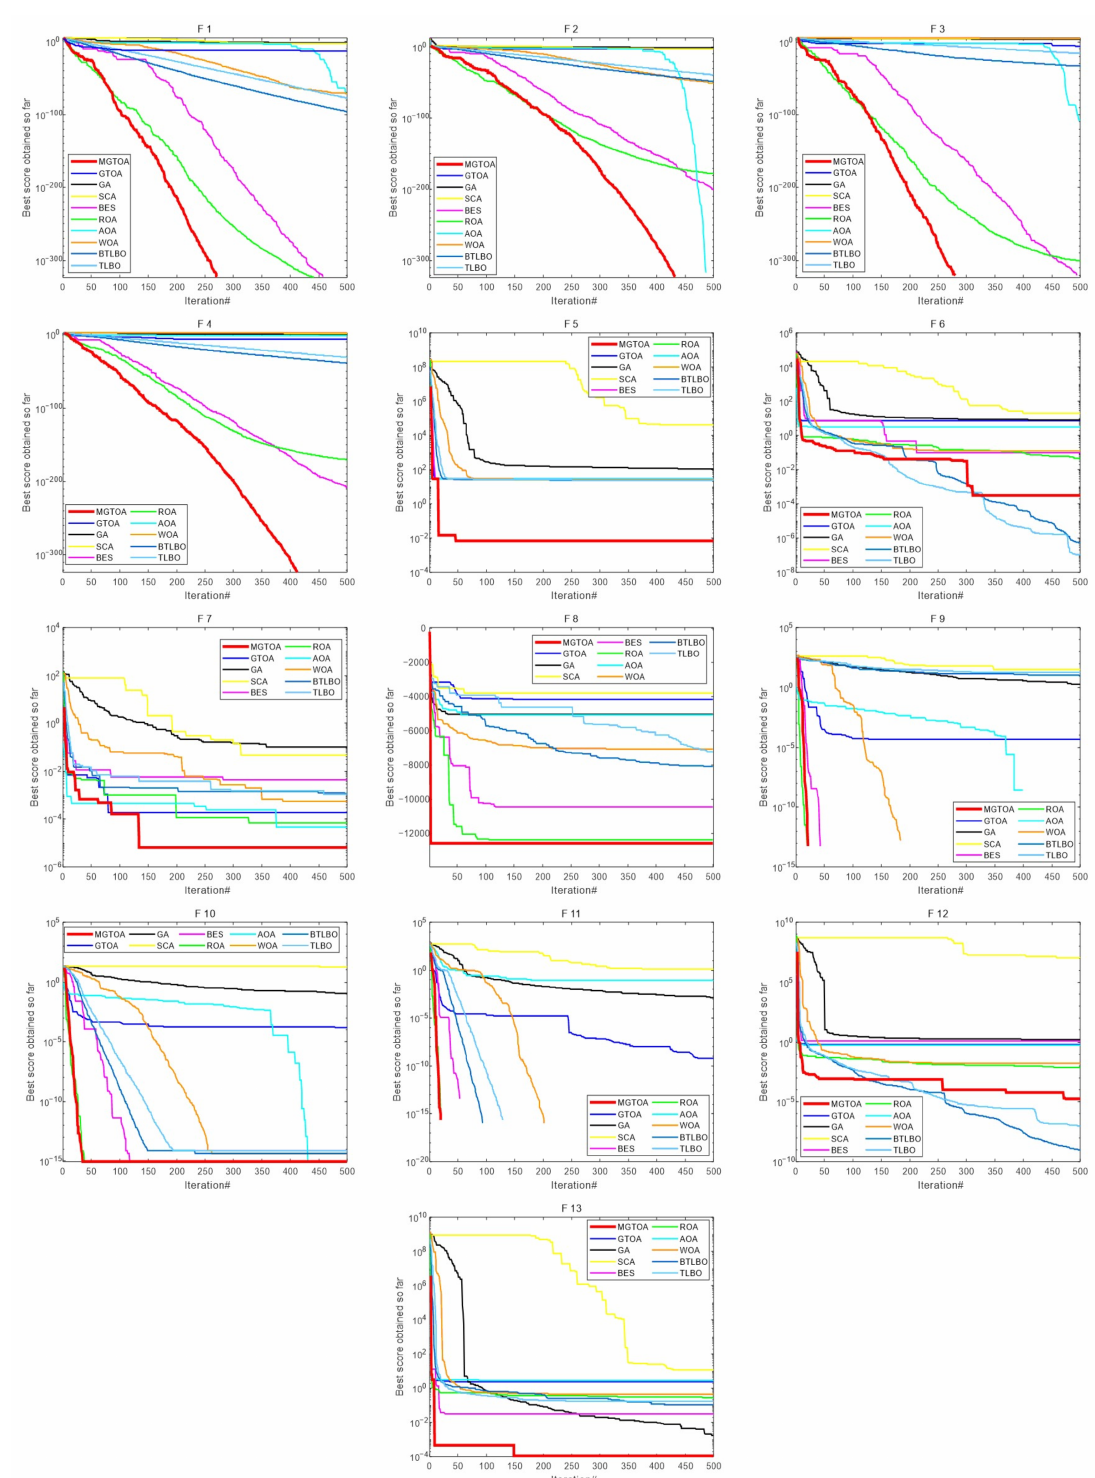
Figure 4. Convergence curves for the optimization algorithms for standard benchmark functions (F1–F13) with dim =